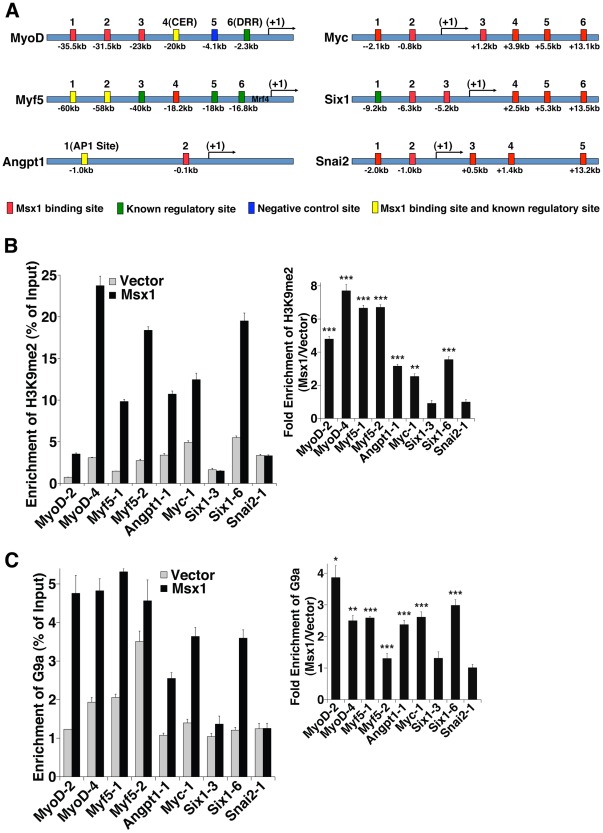
Msx1 genomic binding associates with enrichment of the H3K9me2 repressive mark in myoblast cells.(A) Diagram of six Msx1 repressed target genes [23] showing the positions of Msx1 binding sites and known regulatory regions as well as their overlap; also shown is a negative control site. DRR: Distal Regulatory Region. (B) ChIP-qPCR analyses showing the relative levels of H3K9me2 at Msx1 genomic binding sites in C2C12 cells. ChIP data are expressed as relative enrichment of H3K9me2 normalized to input in C2C12 cells expressing or lacking Msx1. (Inset) ChIP data expressed as fold enrichment of H3K9me2 in C2C12 cells expressing Msx1 versus the control cells lacking Msx1 (and normalized to input). (C) ChIP-qPCR assays were done using C2C12 cells expressing Flag-Msx1 or a control vector to evaluate binding of G9a to the indicated Msx1 target sequences. ChIP data are expressed as relative enrichment of G9a binding normalized to input in C2C12 cells expressing or lacking Msx1. (Inset) ChIP data are expressed as fold enrichment of G9a binding in C2C12 cells expressing Msx1 versus the control cells lacking Msx1 (and normalized to input). In B and C, the * indicate the following: ***P<0.0001, **P<0.001, *P<0.01.